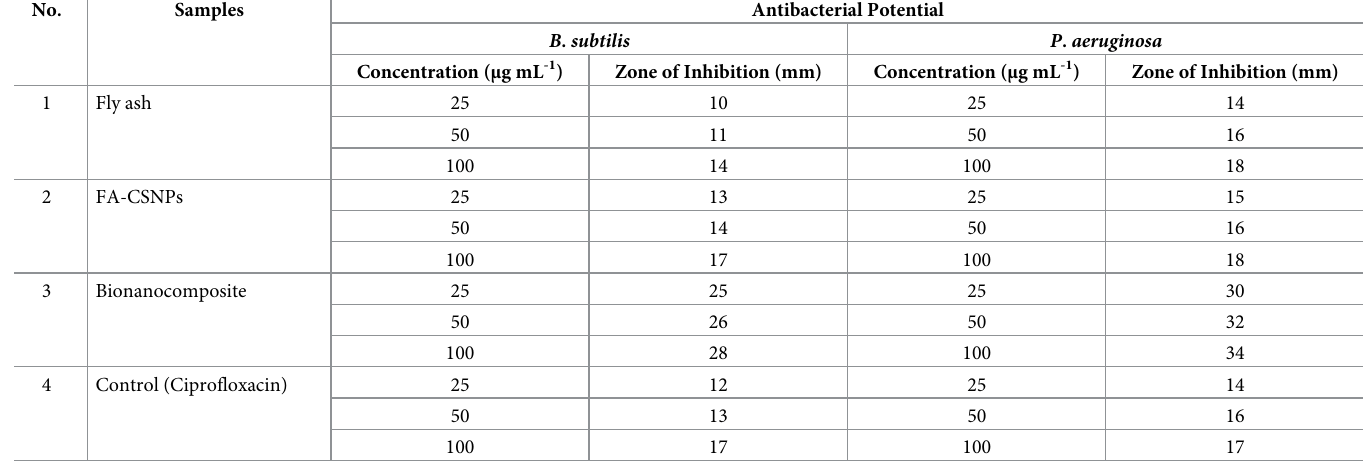
Table 1. Antibacterial potential of FA, FA–CSNPs, sunflower oil/FA–CSNPs bionanocomposite against B . subtilis (Gram–positive) and P . aeruginosa (Gram–nega- tive) bacteria. No.